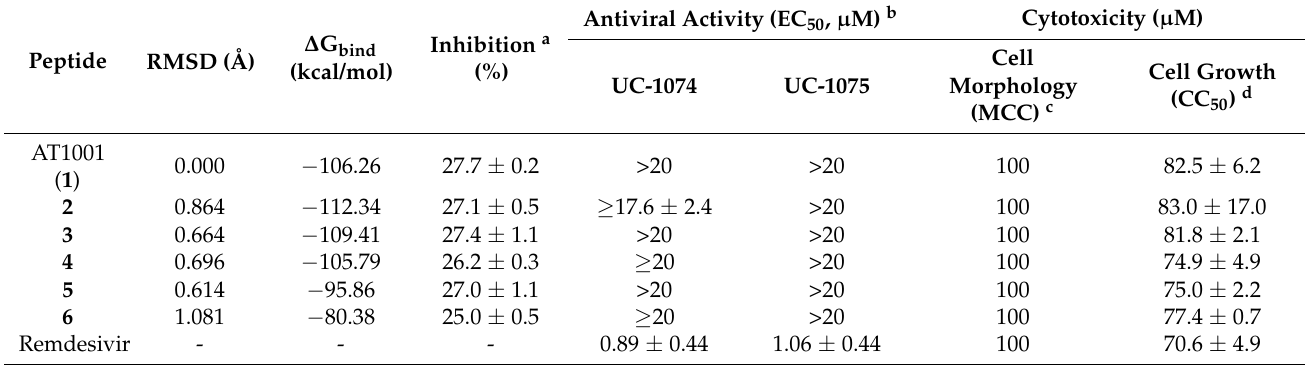
Table 1. Root mead square deviation (RMSD), predicted ∆ G bind , enzymatic inhibition, and activity against SARS-CoV-2 in Vero cells of 1 – 6